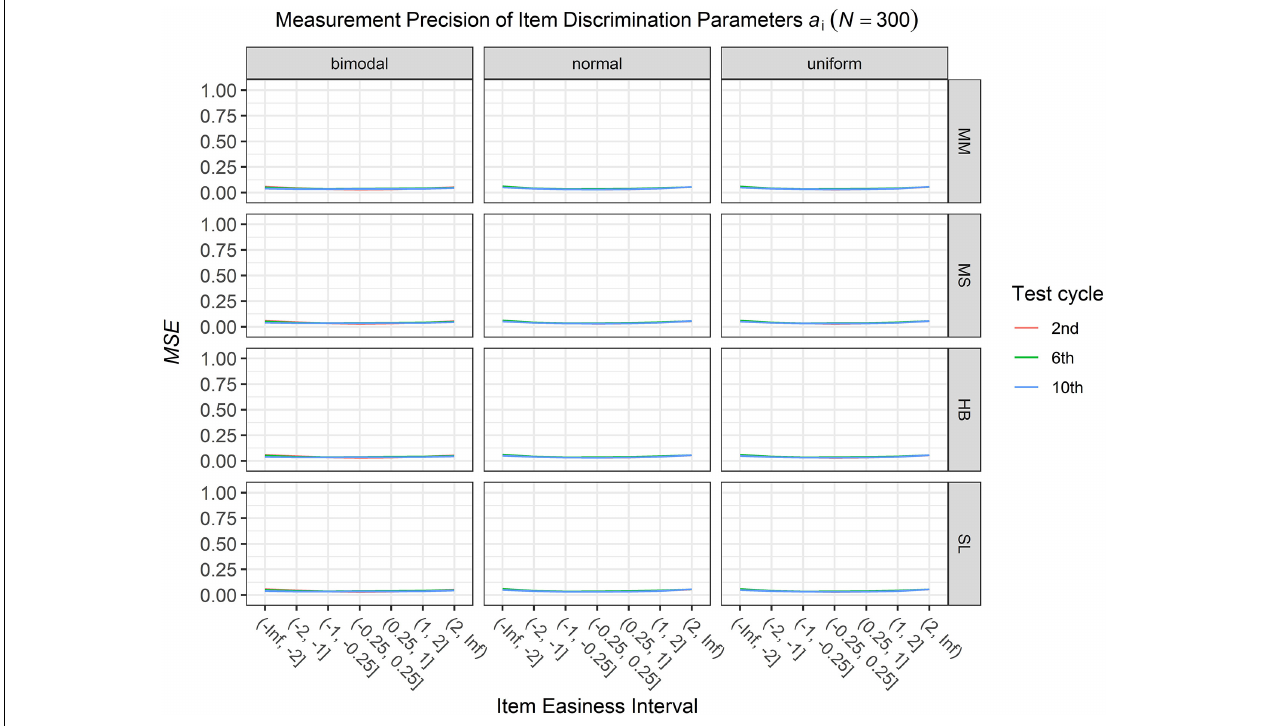
FIGURE 3 | Conditional mean squared error ( MSE ) of the item discrimination a i for specific item easiness intervals after the 2nd, 6th, and 10th test cycle in the continuous calibration strategy with a sample size per test cycle of N = 300 for different common item difficulty distributions and different scale transformation methods (MM = Mean/Mean, MS = Mean/Sigma, HB = Haebara, SL =